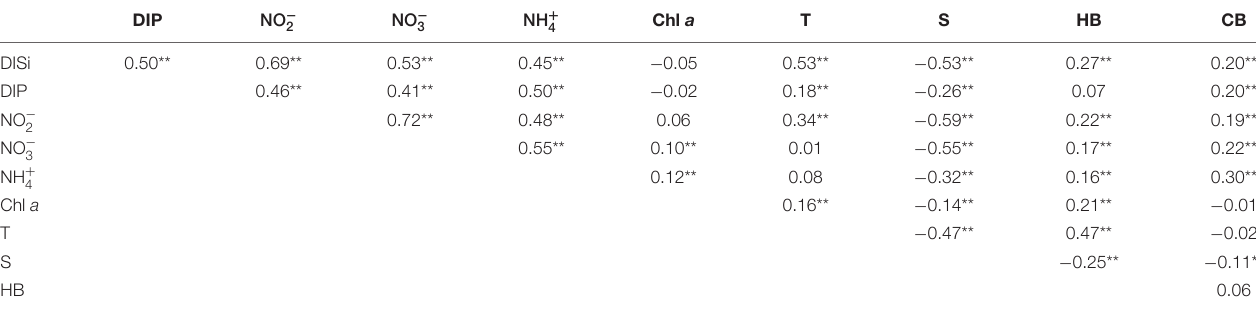
FIGURE 6 | Interannual variation of CB abundance ( × 10 3 MPN/100 ml) in Jiaozhou Bay. Columns with different lengths in 12 stations show the average abundance of CB in: (A) the first stage; (B) the second stage; and (C) the third stage. The pie charts on the maps represent the proportion of the average abundance of CB in different areas. Interannual variation in CB abundance of four areas in Jiaozhou Bay: (D) the estuary area; (E) the inner bay area; (F) the bay mouth area; and (G) the outer bay area. The red, green, and blue dotted lines represent the average abundances in the first stage (2004–2007), the second stage (2008–2013), and the third stage (2014–2017), respectively. The black dotted line (threshold value) represents the Class IV standard for CB abundance specified by the NSQS. TABLE 2 | Spearman correlation analysis between environmental factors and the abundance of